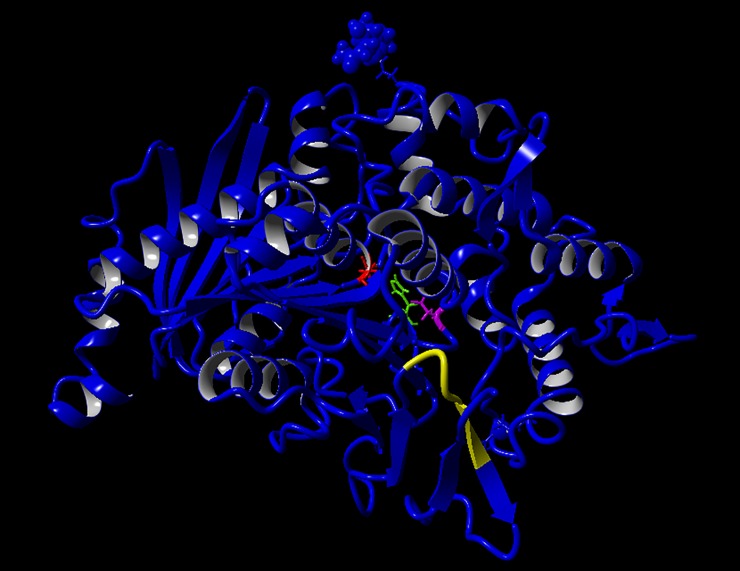
Hybrid model of FoFaeC.Blue: fragment 42–542 from model 1; Yellow: fragment 518–523 from model 2; Red: Ser201; Green: His452; Magenta: Asp412.